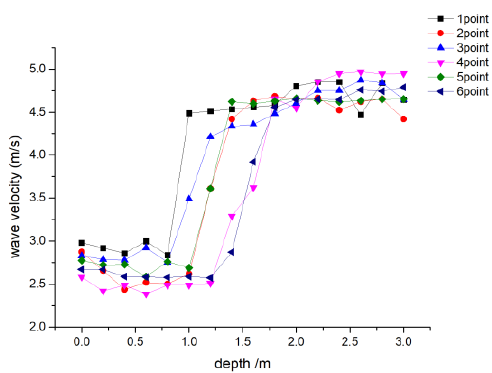
wave velocity. The acoustic detection results are shown in Figure 12.